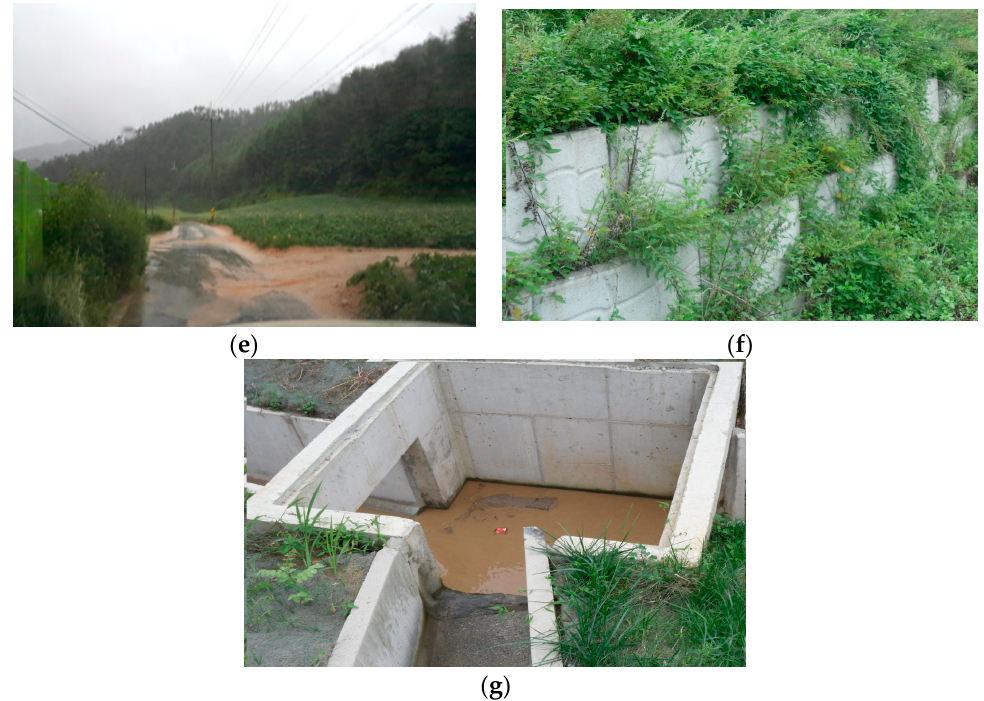
Figure 3. BMPs in the Lake Soyang basin: ( a ) multistage sedimentation basin; ( b ) gabion wall; ( c ) slope protection work; ( d ) concrete channel; ( e ) current situation of sediment runoff on the roadside in the Jaun area on 18 July 2016; ( f ) vegetated retaining wall; and ( g ) drop structure.